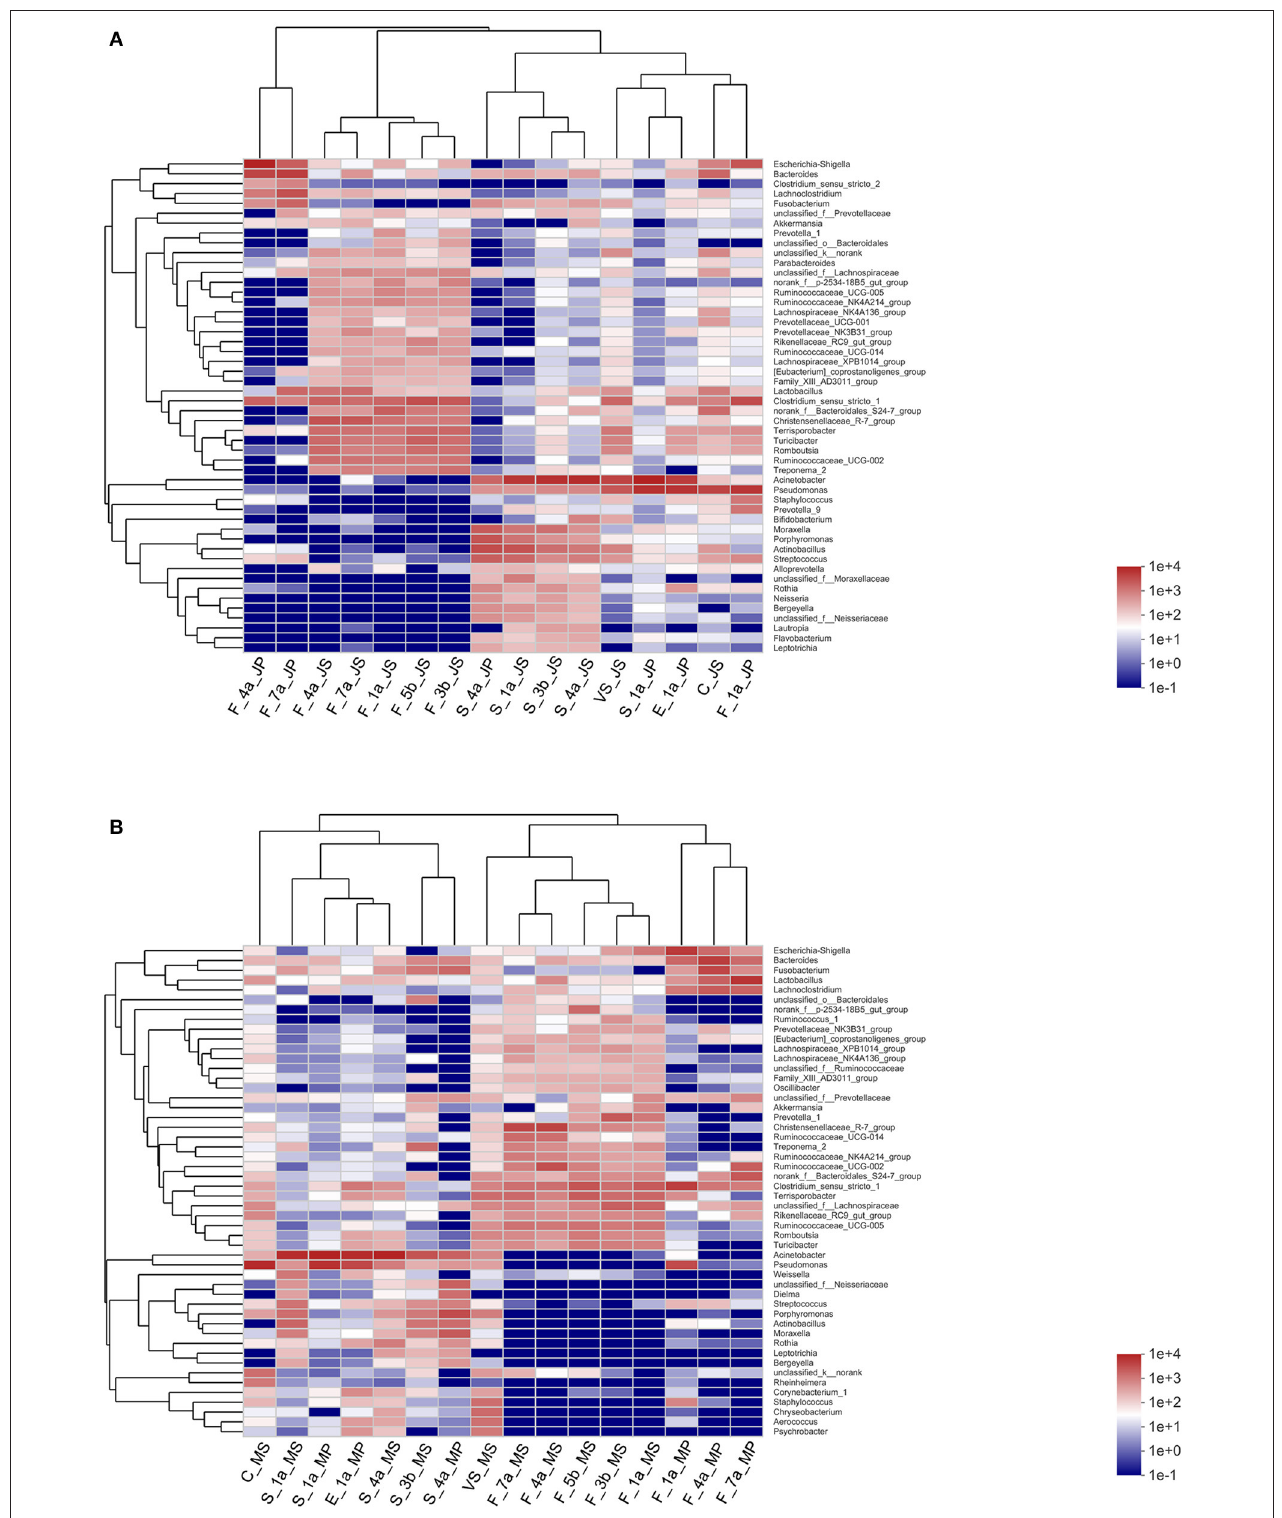
FIGURE 5 | Hierarchical clustering heatmap of the piglets and maternal factors and postpartum environmental samples based on association with microbiota. (A) Heatmap analysis results of correlation of Jinfen White pig. (B) Heatmap analysis results of correlation of Mashen pig. Columns correspond to the piglets and maternal factors and postpartum environmental samples; rows correspond to the top 50 abundant microbiota based on Spearman’s rank correlation coefficient. Red and blue denote positive and negative associations, respectively.